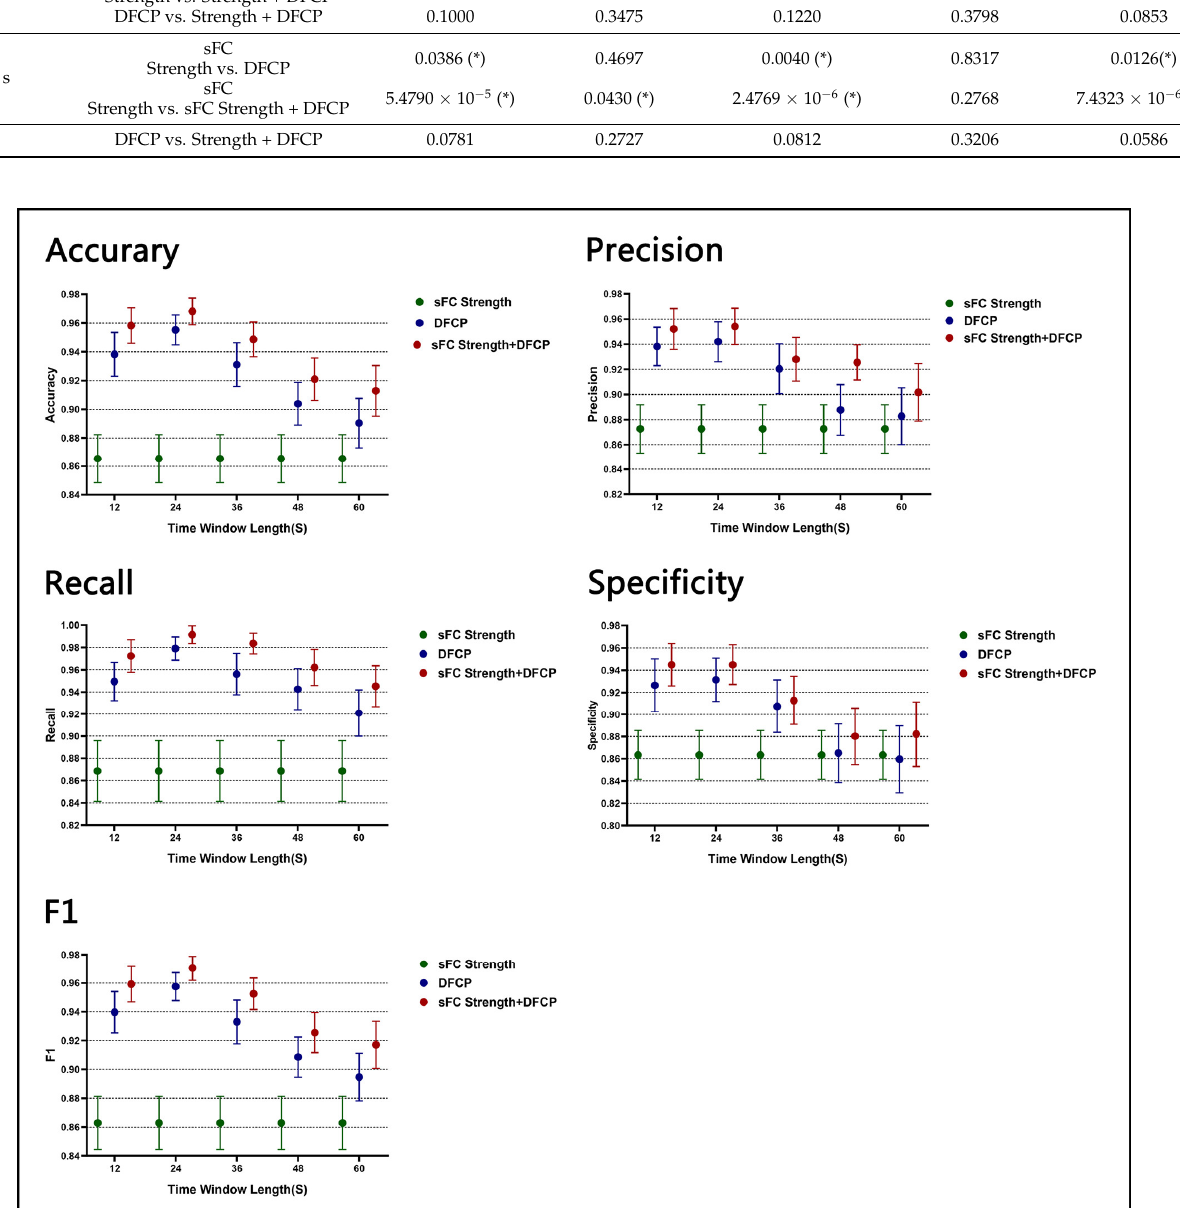
Figure 4. The classification accuracy, precision, specificity, recall, and F1 of sFC strength, DFCP, and sFC strength+DFCP approaches between the migraine patients and normal control (NC) subjects. On the X -axis, labels t = 12–60 indicate the time window length for DFCP, and Y -axis indicates the mean classification accuracy, precision, specificity, recall, and F1 on CI 95%. To illustrate the reliability and reproducibility of the three approaches, we computed the same classification performance metrics based on the ICBM test set with the window length from 12 s to 60 s. The mean value, the standard deviation, and the mean with 95% CI of each classification performance metric under five window lengths for each classifi- cation approach are displayed in Supplementary Table S1. The statistical p -values and significant differences in classification performance metrics along three approaches at the individual level under five different time window lengths, including accuracy, precision, recall, specificity, and F1, are showed in Supplementary Table S2. The mean values with 95% CI of accuracy, precision, recall, specificity, and F1 for all classification approaches are illustrated in Supplementary Figure S1.